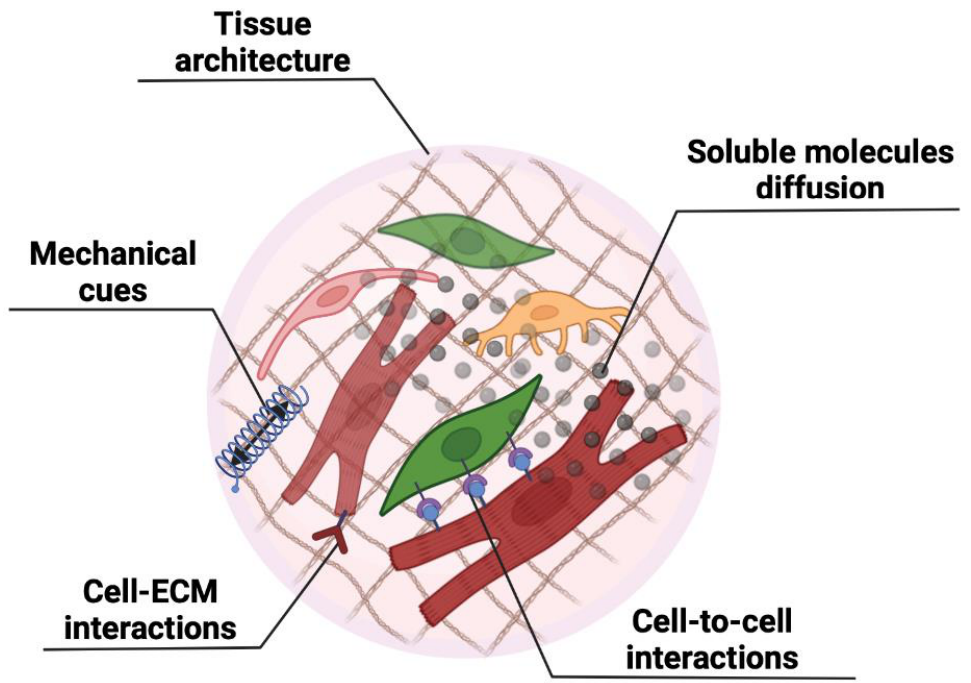
Figure 1. Summary of the main advantages of multicellularity and 3D architecture in modelling systems. Several features can be enhanced and boosted when co-culturing multiple cell types in 3D microenvironments. They include complex tissue architecture, the diffusion of paracrine soluble molecules, the establishment of cell-to-cell and cell – ECM interactions, and integrated mechanical sensing and responses. This figure was created with Biorender software.